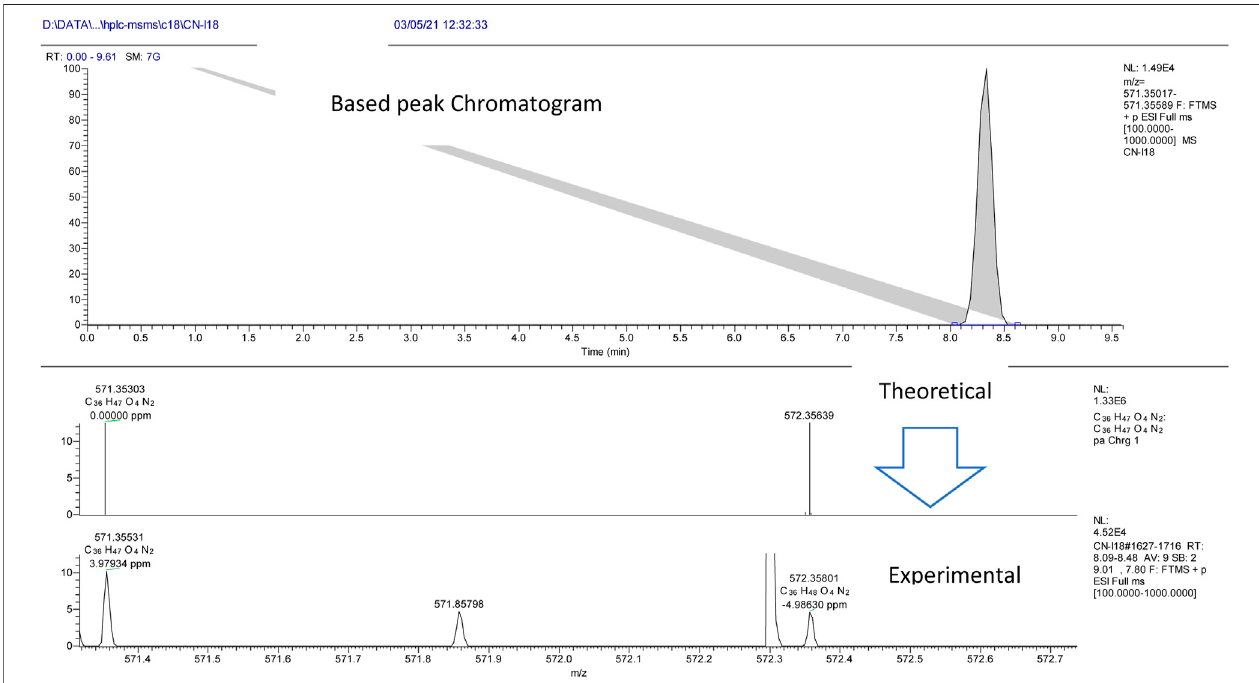
FIGURE 5 | HPLC-MS extracted ion chromatogram of the compound entitled I/A12 at m/z 635.38424 (RT: 5.7 min).